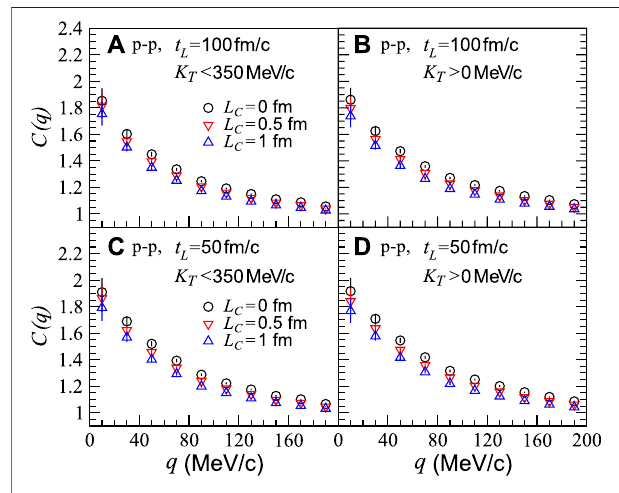
FIGURE 2 | Two-pion correlation functions C ( q ) for pion-emitting sources with different coherent emission length values, L C , in the transverse momentum ranges of K T < 500 MeV/ c and K T > 500 MeV/ c , respectively, in (cid:1)(cid:1)(cid:1)(cid:1) √ (cid:3) 200 GeV. Panels (A,B) apply to the temporal Au-Au collisions at s NN limitation parameter t L = 100 fm/ c , while panels (C,D) apply to t L = 50 fm/ c .